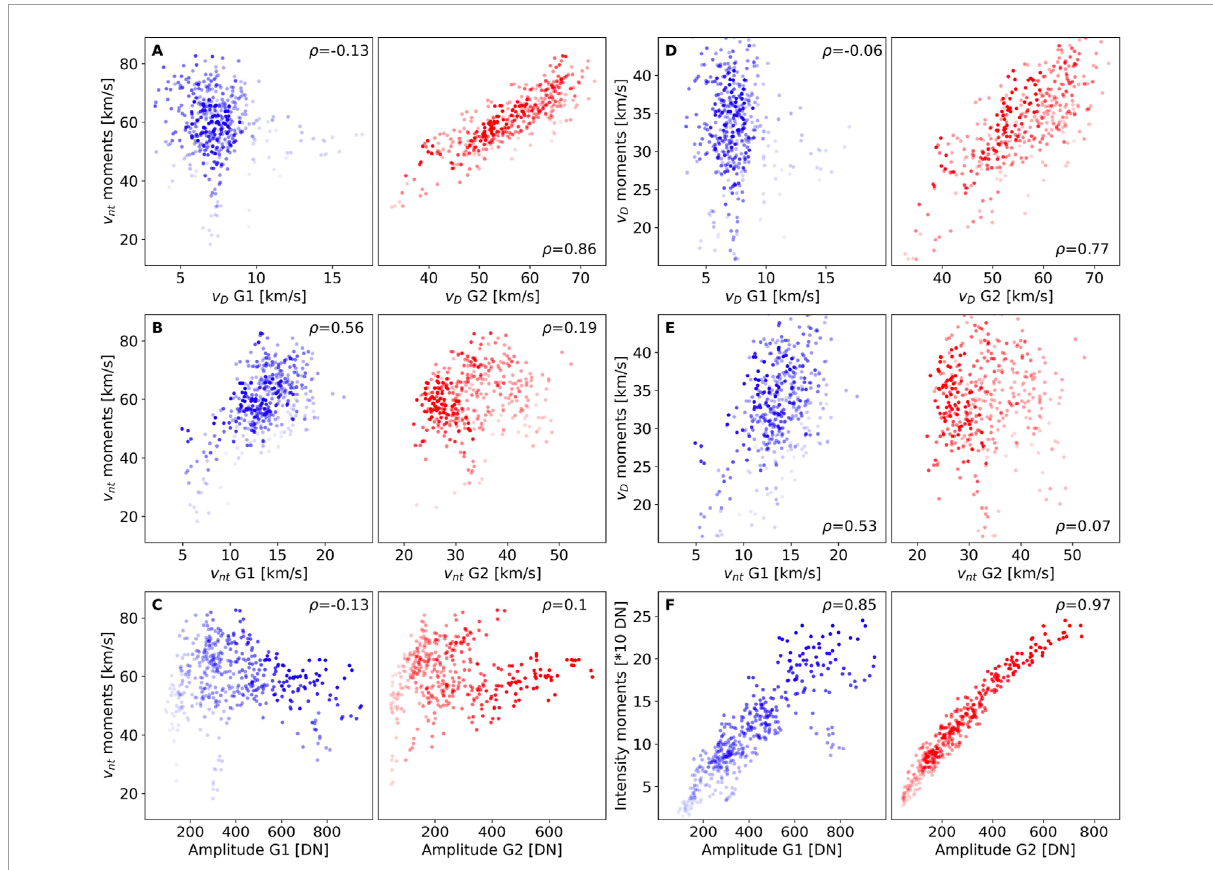
FIGURE 5 Scatterplots detailing the relation between Si IV 1402.77Å line properties determined via the moment analysis (vertical axes) and the parameters of the two Gaussians fitting its spectra (horizontal axes). In each panel, the Pearson correlation coefficient calculated in the respective scatterplot is